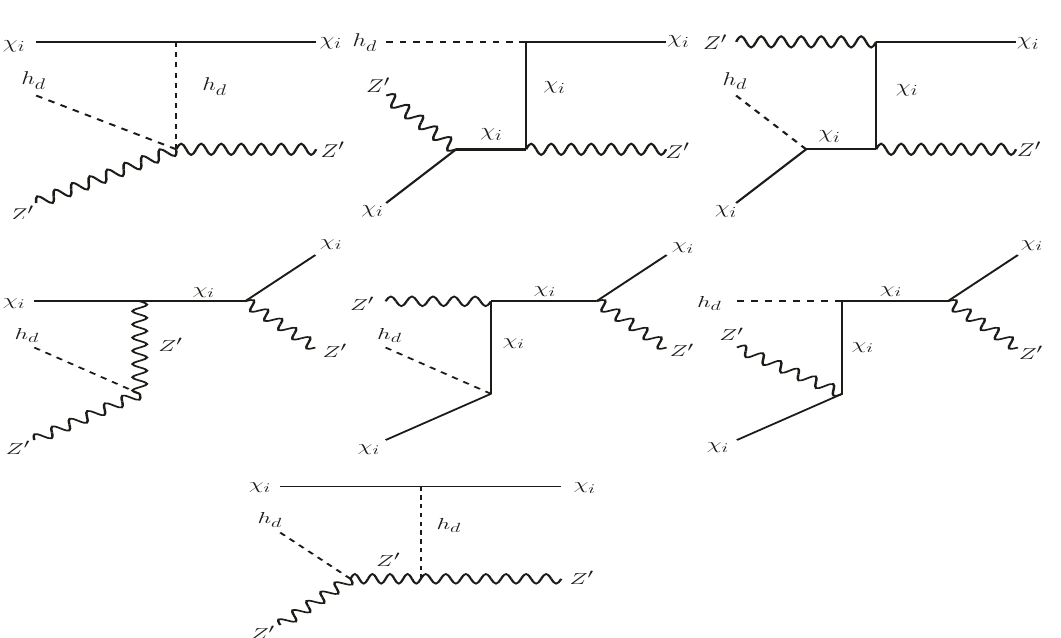
Figure 20 . Feynman diagrams for χ